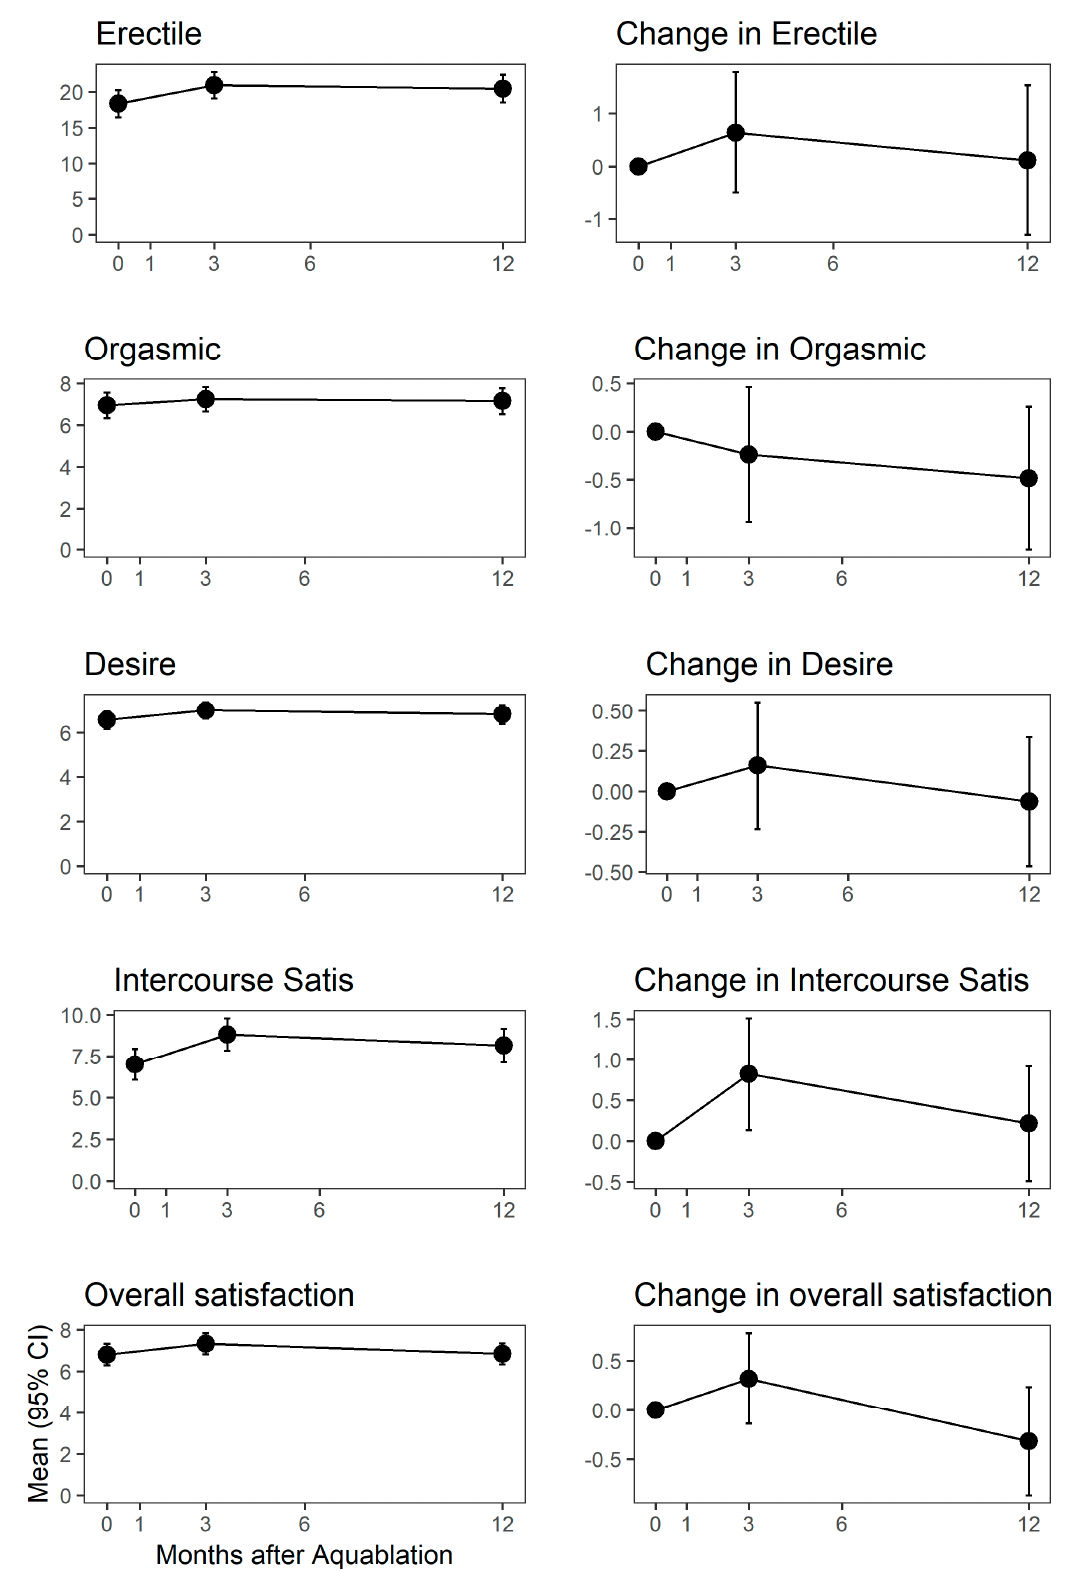
Figure 4. Absolute (y-axis) and change (y-axis) in sexual function scores from the baseline to month 12. Top two plots are MSHQ-Ejd score and bother score. Bottom five plots are IIEF-15 subdomains. Months after Aquablation procedure is the y-axis in all graphs.